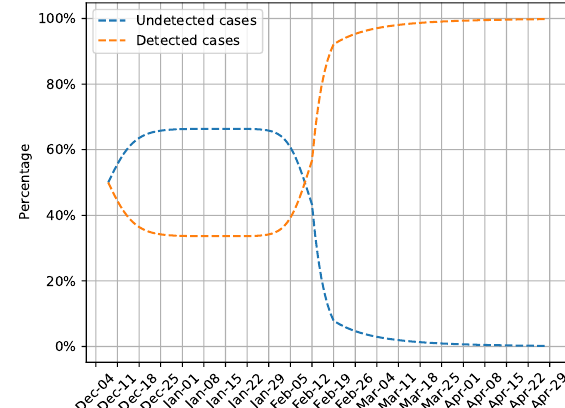
Fig. 3: Percentage repartition of undetected and detected infected individuals among the total number of infected